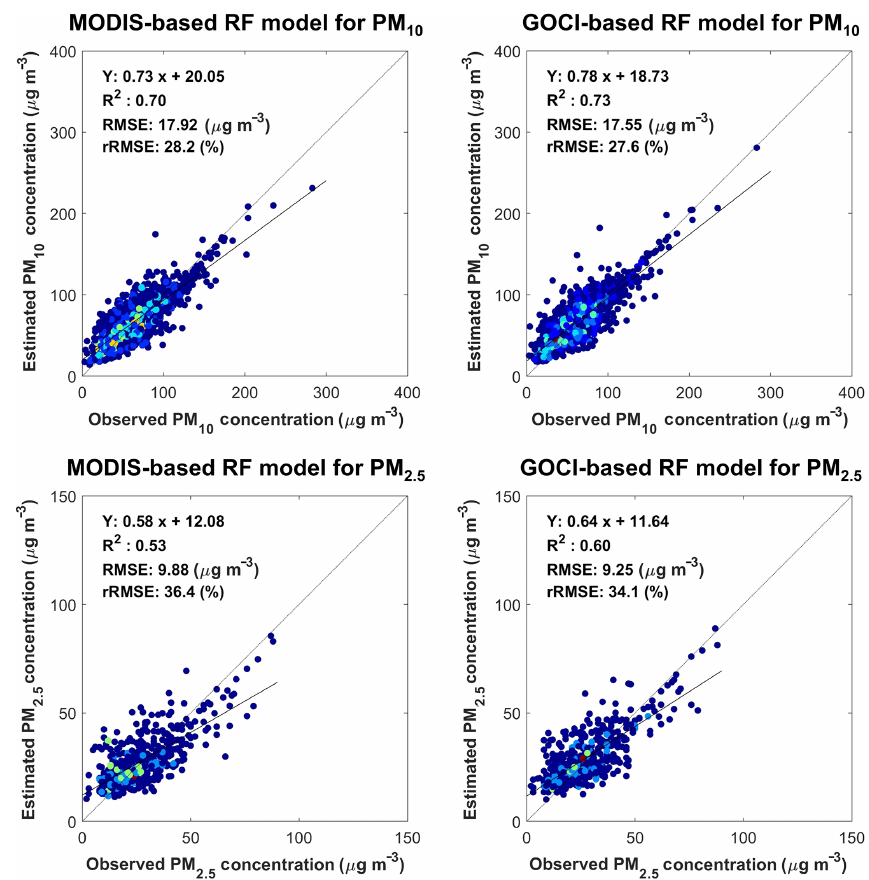
Figure 7. Scatterplots between the estimated and observed particulate matter concentrations when using MODIS- vs. GOCI-based models. The color scheme from blue to red indicates the point density: the blue point means low density, while the red point shows high